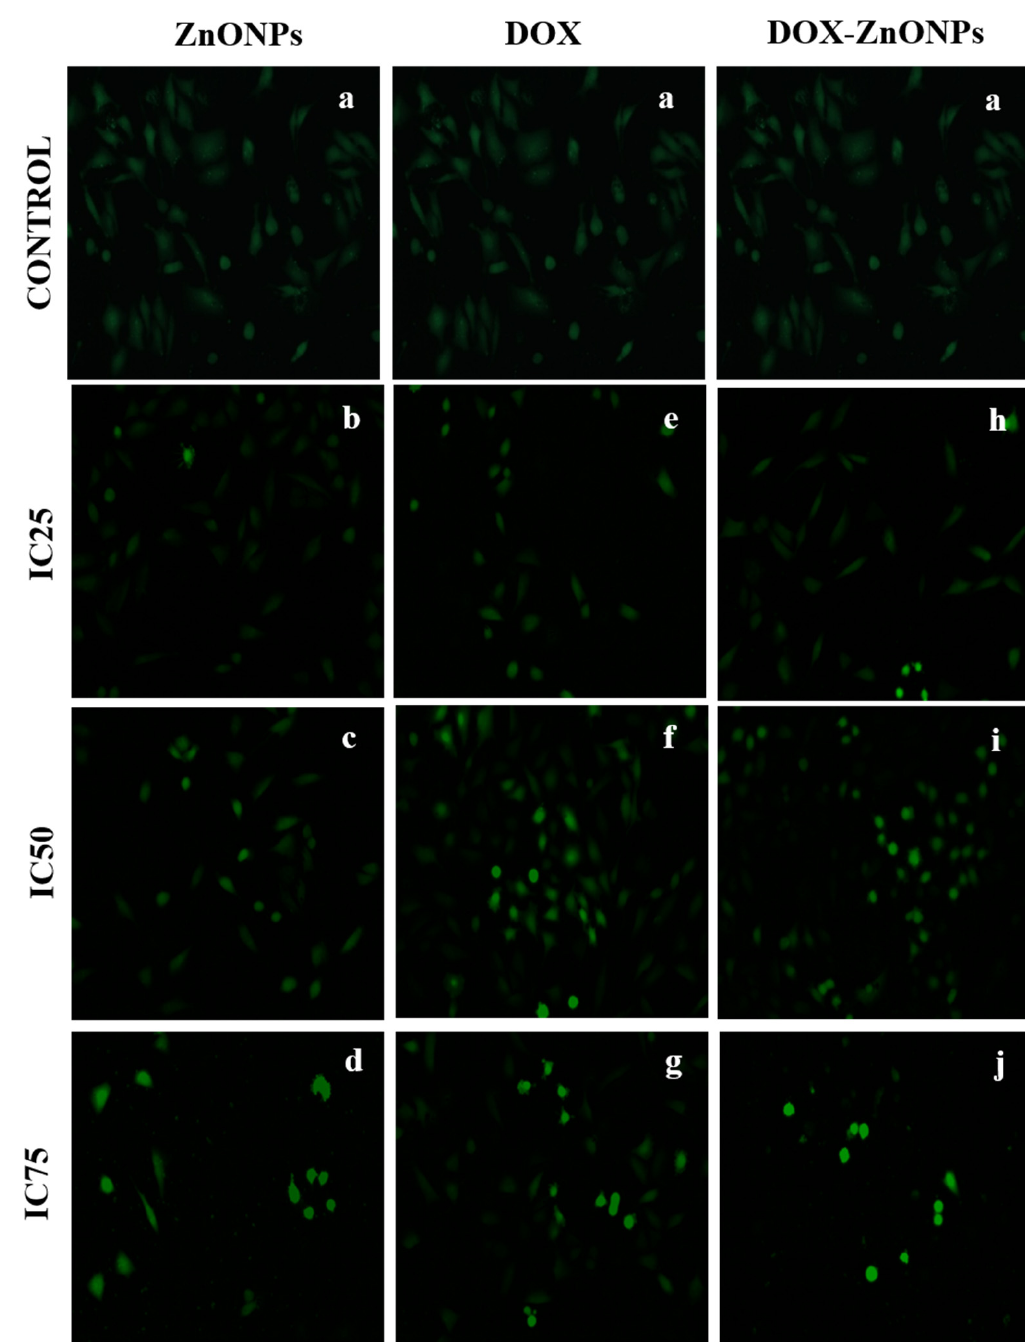
Figure 10. Intracellular ROS generation in A549 cells treated at IC25 [ (b) ZnONPs 27.83 μ g/mL; (e) DOX 0.27 μ g/mL; (h) DOX-ZnONPs 0.079 μ g/mL], IC50 [ (c) ZnONPs 65.3 μ g/mL; (f) DOX 0.56 μ g/mL; (i) DOX-ZnONPs 0.34 μ g/mL] and IC75 [ (d) ZnONPs 70.41 μ g/mL; (g) DOX 0.72 μ g/mL; (j) DOX-ZnONPs 0.69 μ g/mL] concentrations. Vehicle control group image is shown as “a”. Images shown are representative of three independent experiments.